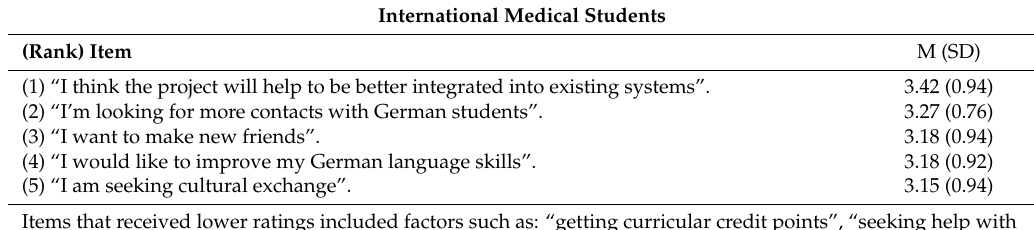
Table 2. Ranking of most important motives for participating in the TP.